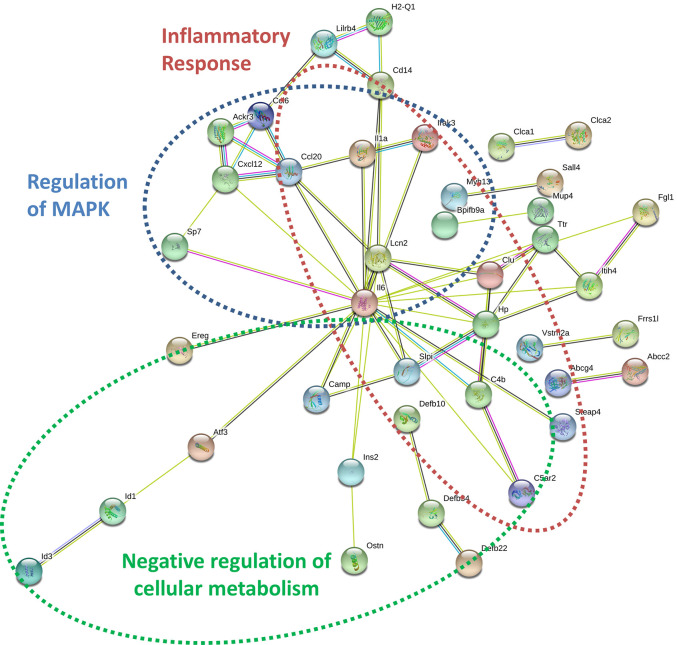
Key signaling pathways are altered in myeloma-associated mouse 3T3-L1 adipocytes. Upregulated genes in MM-3T3-L1s are connected via the central node of Il6 as demonstrated graphically by string-db analysis of 3T3-L1 microarray data.